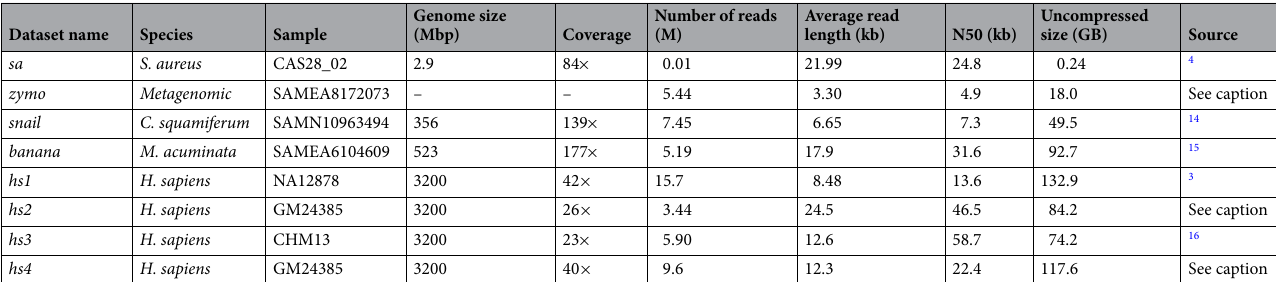
Table 1. Datasets used for experiments. The uncompressed size refers to the file size obtained by removing the quality scores and sequence identifiers from the FASTQ files. N50 is a robust measure for read lengths, with the reads with length above the N50 metric capturing 50% of the data. The zymo dataset was obtained from a bonito basecalling of the Zymo sample (details at https:// github. com/ Kirk3 gaard/ 2020- 05- 20_ ZymoM ock_ Q20EA). The hs 2 and hs 4 datasets were was obtained from the ONT Open Datasets (https:// labs. epi2me. io/ gm243 85_ 2020. 09/ and https:// labs. epi2me. io/ gm243 85_ q20_ 2021. 10/, respectively).